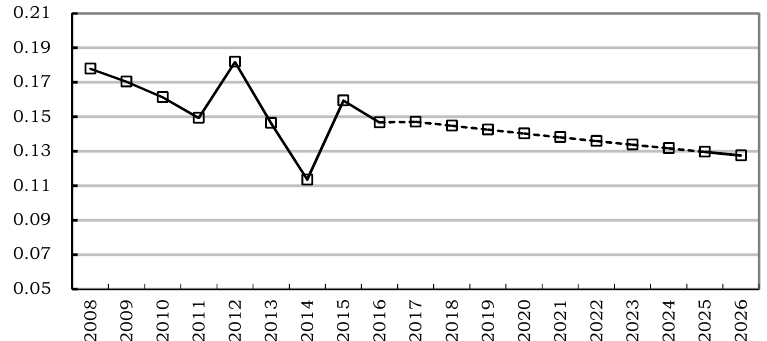
Figure 2. The actual and predicted Theil index of Chinese provincial community health service efficiency.